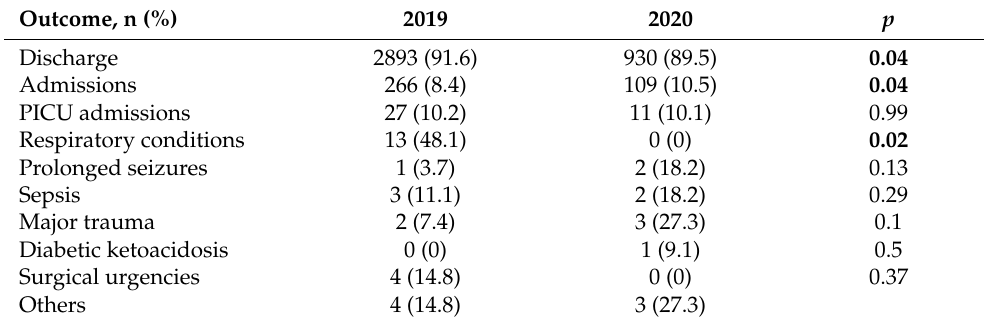
Table 4. Outcome of the population accessing the Verona pediatric emergency department in